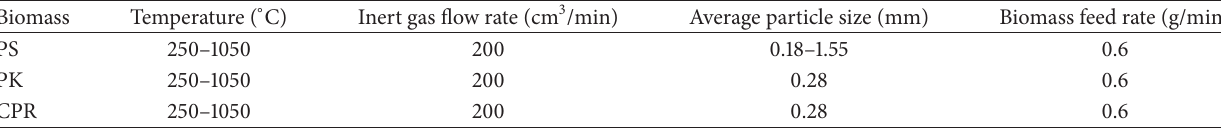
Table 1: Experimental conditions for biomass pyrolysis study in a free-fall